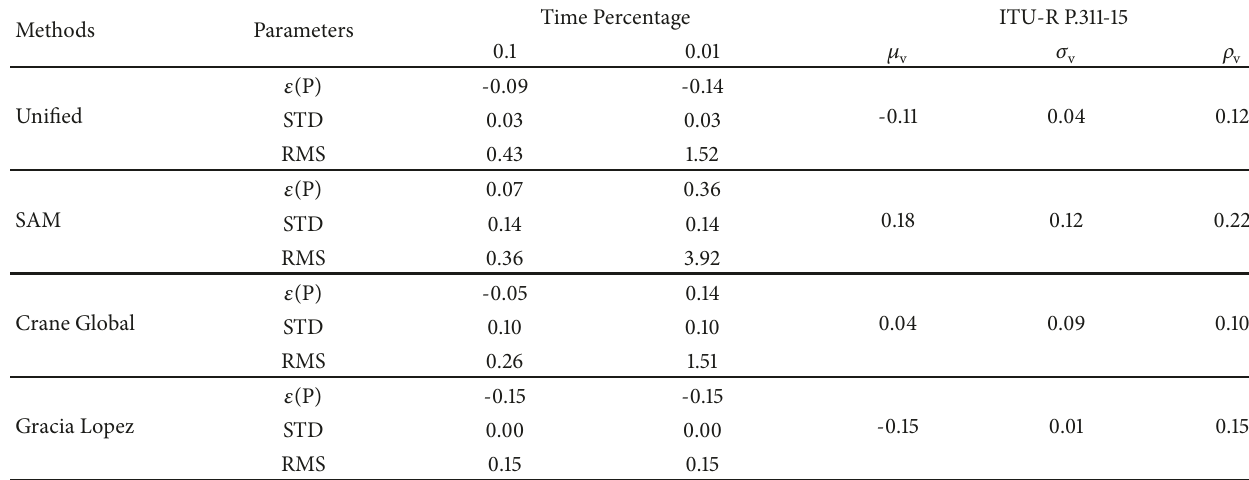
Table 4: Calculated error percentage over 0.1% and 0.01% of the